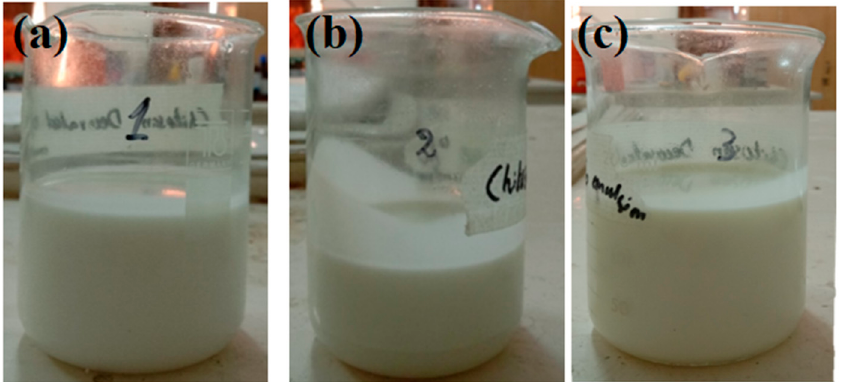
Figure 1. ( a ) O/W nanoemulsion, ( b ) chitosan-decorated O/W nanoemulsion and ( c ) chitosan-decorated O/W/O multiple nanoemulsion .